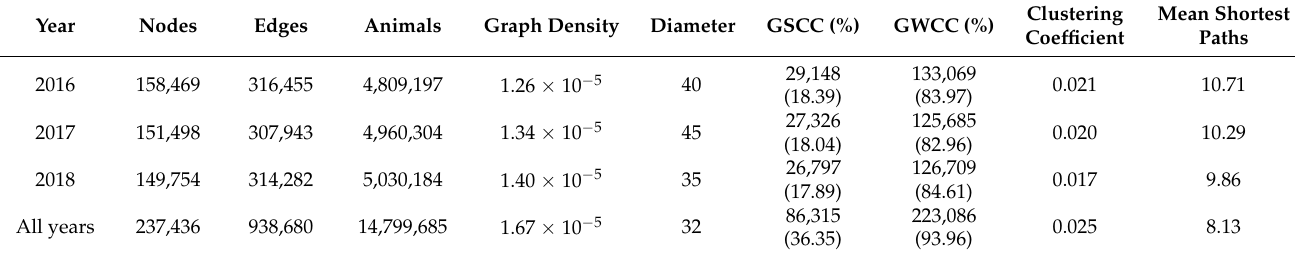
Table 2. Static network description. Network parameters of RS state by year and for all years.